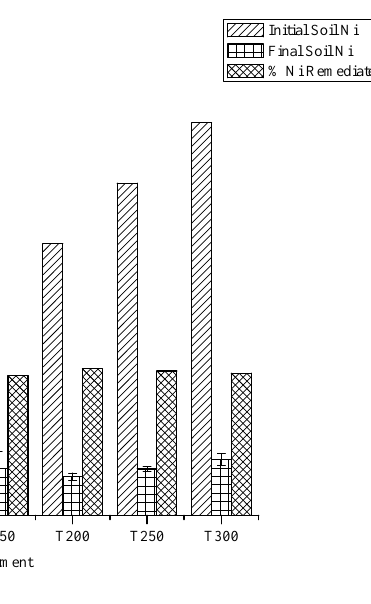
Figure 4: Ni levels in the soil before and after the